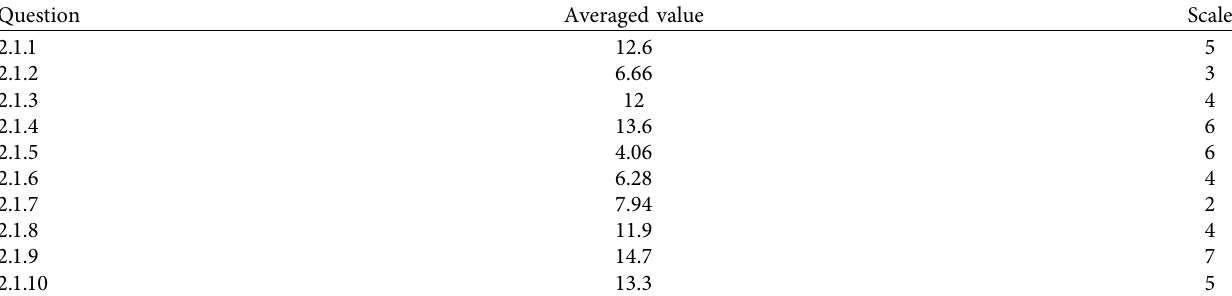
Table 6: Averaged value and corresponding scale for part two of the questionnaire.